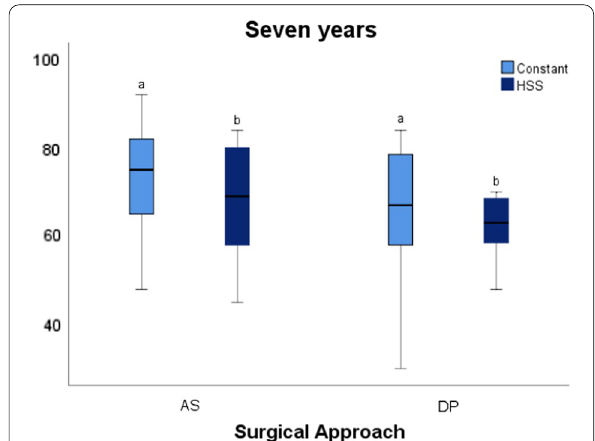
Fig. 2 Boxplot chart where we can observe function (according to Constant and HSS) in both approaches used 7 years after surgery. Same letters indicate no statistically significant differences between them ( p < 0.05, a and b ). AS anterosuperior, DP